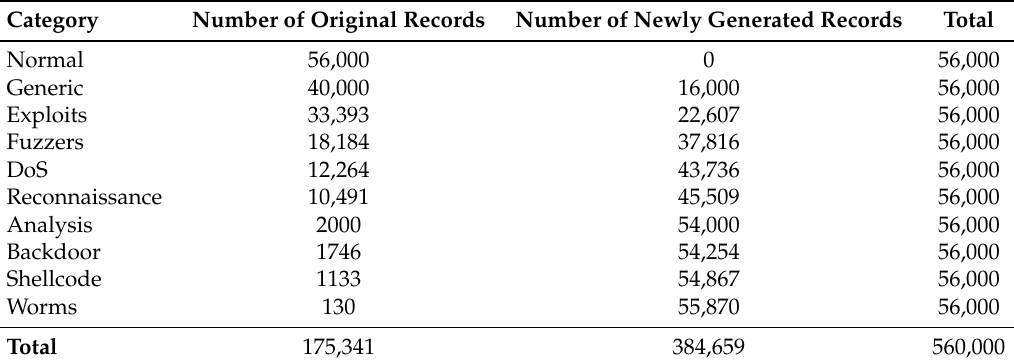
Table 5. Number of samples generated on the UNSW-NB15 training